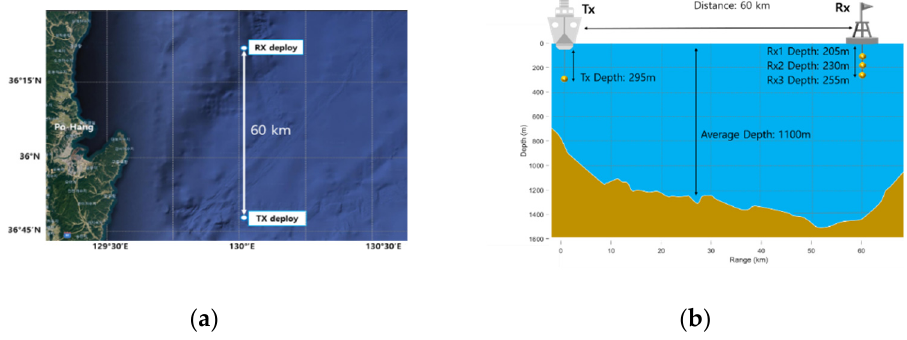
Figure 10. Ocean experiment: ( a ) location, ( b ) configuration.